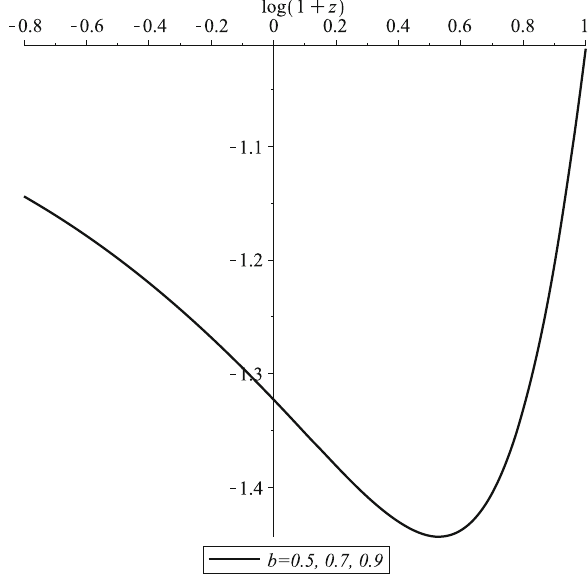
Fig. 2 Decelerationparameter q for b = 0 . 5 , 0 . 7 , 0 . 9.Allofthecurves meet. Here, the horizontal axis shows log ( 1 + z ) and the vertical axis shows the value of q